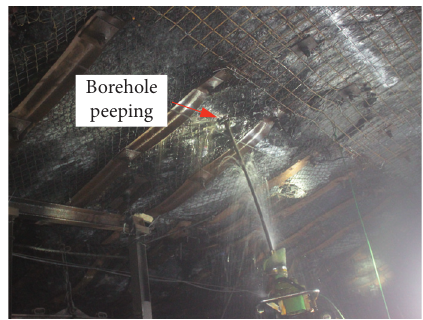
Figure 11: Illustration of borehole peeping construction.